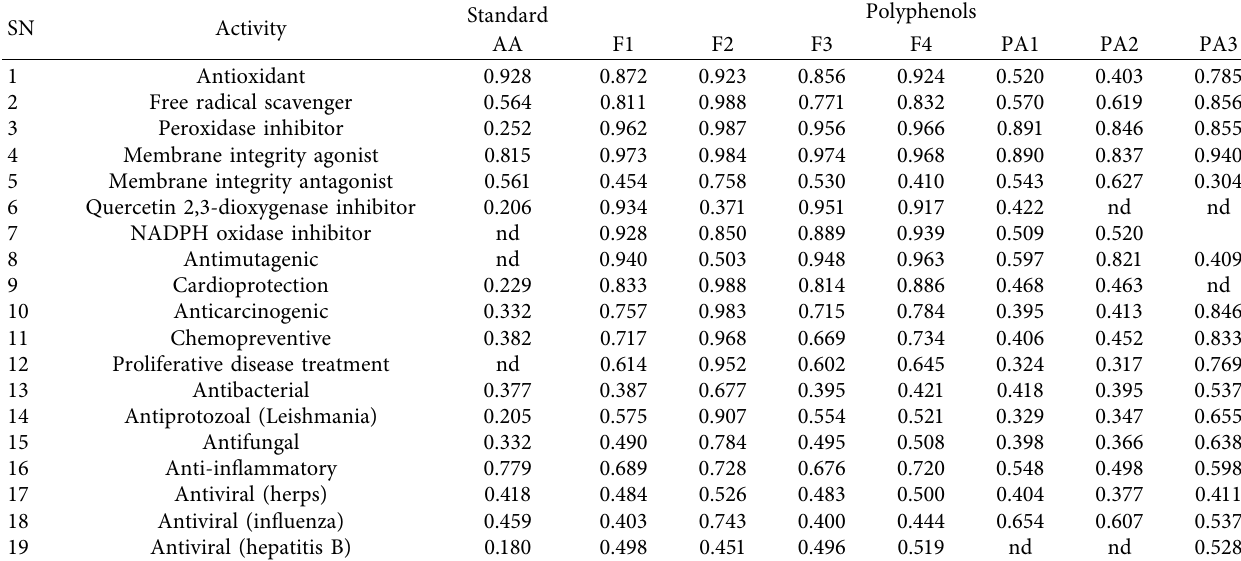
Table 4: Probability of activity (Pa) summary for the favonoids and phenolic acids.